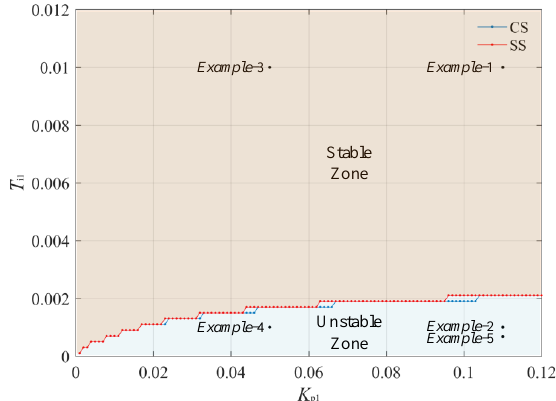
Figure 8. Comparison of stable boundary between SS and cascade structure (CS).